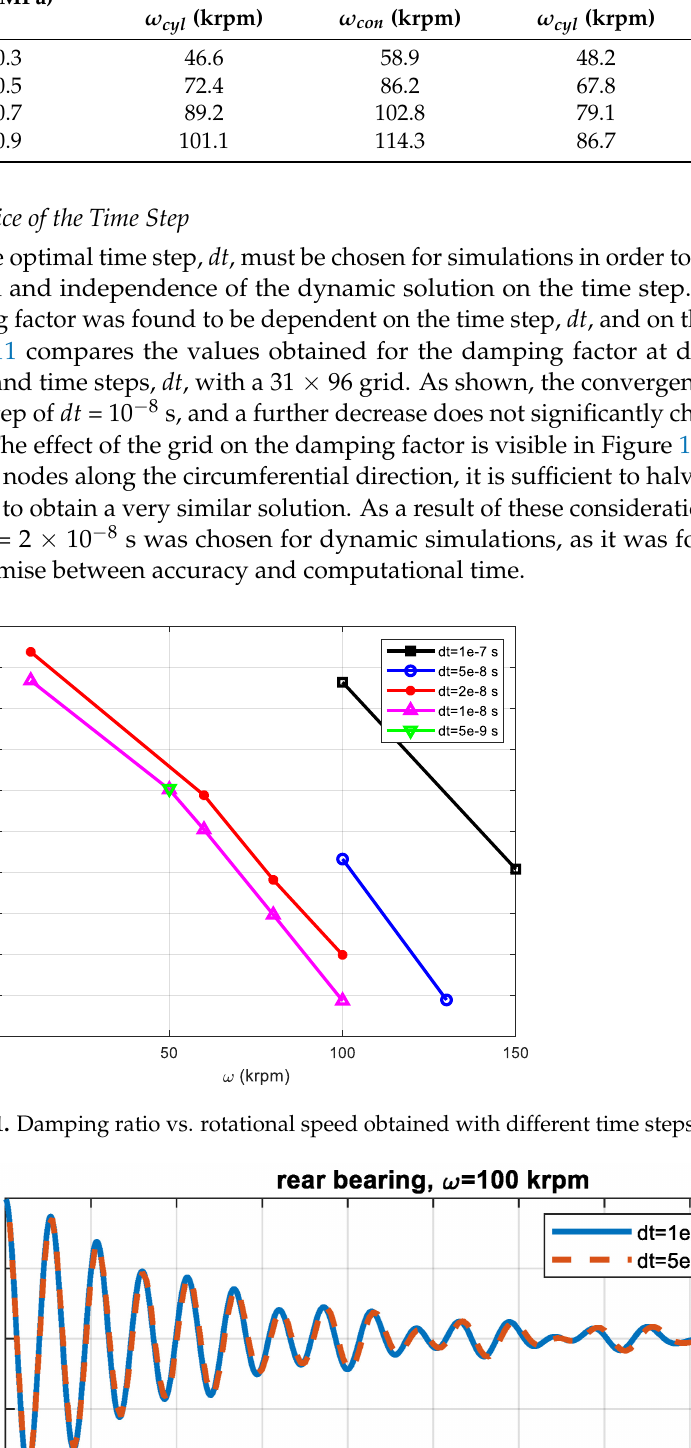
Figure 12. Comparison of vibrations obtained on front and rear bearings with 31 × 96 and 31 × 48 grids; the two curves match fairly well in case the time step is halved when doubling the grid points. 4.7. Damped Natural Frequencies and Damping-Factor Identification The damped natural frequencies and the damping factors were evaluated for the dis- placements along the x and y directions by the rotor in correspondence of planes at z = 0 (at the right edge of the front journal bearing) and at z = z L = 126 mm (at the left edge of the rear journal bearing). Moreover, to better identify both the cylindrical and the conical modes, the center-of-mass displacement, 𝑦 𝐺 , and the tilting angles, 𝜗 𝑥 and 𝜗 𝑦 , were con- sidered. Two different initial conditions were simulated since the frequency content of the spectra of the system response may depend on how the system is excited. Condition 1 is defined by: